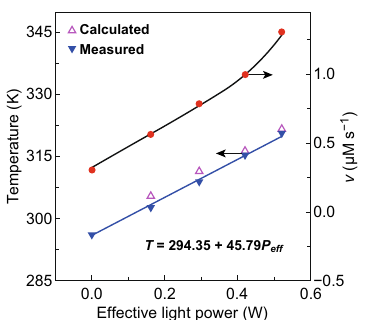
Fig. 3 Photothermally induced increase in (triangles) temperature of the reaction solution and (solid red dots) reaction rate in the presence of the RuOOH/SiO x composite particles as a photothermal catalyst. Blue triangles indicate the temperature measured by the thermocou- ple probe under the illumination of different effective light powers ( P eff ), showing a linear dependence. Violet triangles correspond to the reaction temperatures calculated from the measured reaction rates (solid red dots) according to the Arrhenius equation. (Color figure